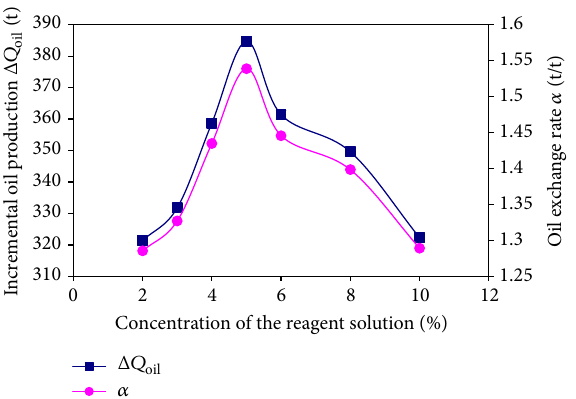
Figure 14: The incremental oil production and oil exchange rates at different well shut-in time